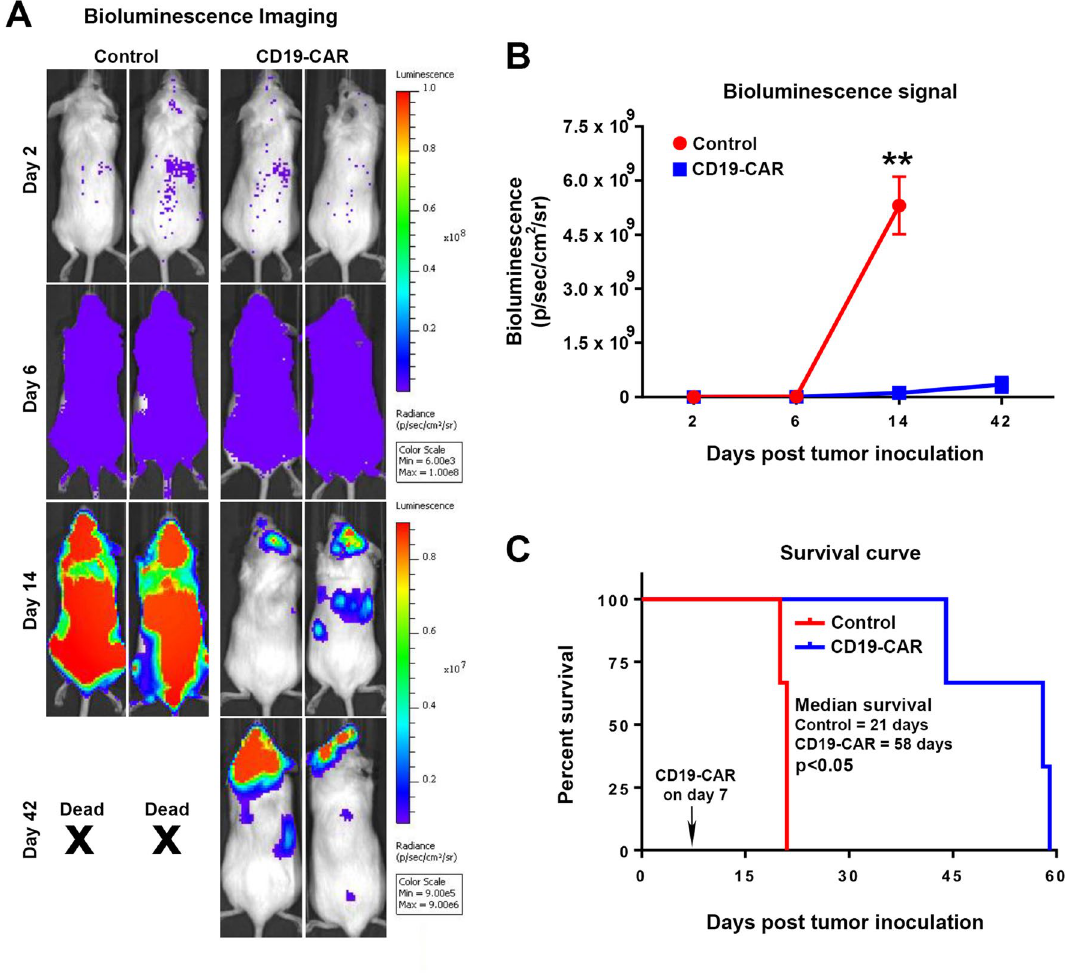
Figure 8. Utilizing Luc146-1H2 expressing target cells for in vivo experiments. ( A ) 6-week-old NOD.Scid- Gamma (NSG) mice were injected with one million Nam6-Luc146-1H2 cells via tail vein. Bio-Luminescence Imaging (BLI) was performed on days 2 and 6 post injection to confirm the engraftment of tumor cells (Nam6- Luc146-1H2) in mice. Post confirmation, on day 7 mice were randomly divided into control (parental-T cells) and CD19-CAR (3 × 10 6 CAR positive cells) treatment groups and were injected with respective cells via tail vein. Representative serial BLI images of mice on days 2, 6, 14 and 42 of indicated groups are shown. ( B ) Tumor burden, as measured by relative luminescence measurements of serial BLI imaging from control and CD19- CAR-T treated mice. ( C ) Survival curves (Kaplan–Meier) of mice bearing Nalm6-Luc146-1H2 cells treated with parental-T cells (control) or CD19-CAR-T cells are shown (n = 3 in each group). The survival curve was generated in GraphPad Prism 5 software. Statistically significant differences are shown by asterisks (**) at a level of P <